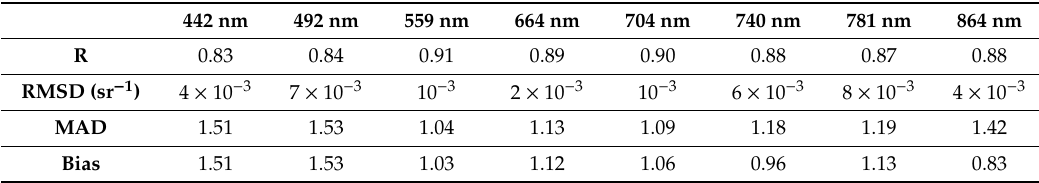
Figure 5. Cross-sensor agreement analyses between the R rs data derived from PRISMA (resampled to Sentinel-2 bands) and Sentinel-2 (acquired on 23 April 2020). Table 3. The agreement statistics for the cross-sensor comparison of R rs at different wavelengths derived from PRISMA and Sentinel-2 data.